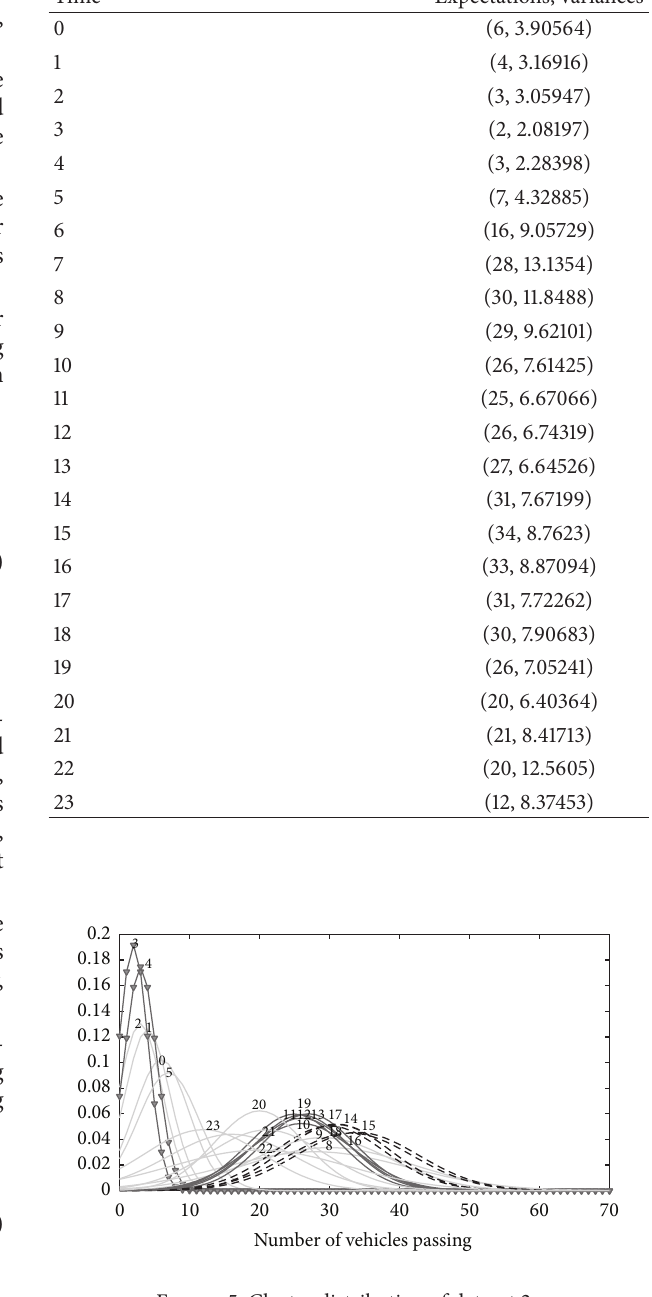
Figure 5: Cluster distribution of dataset